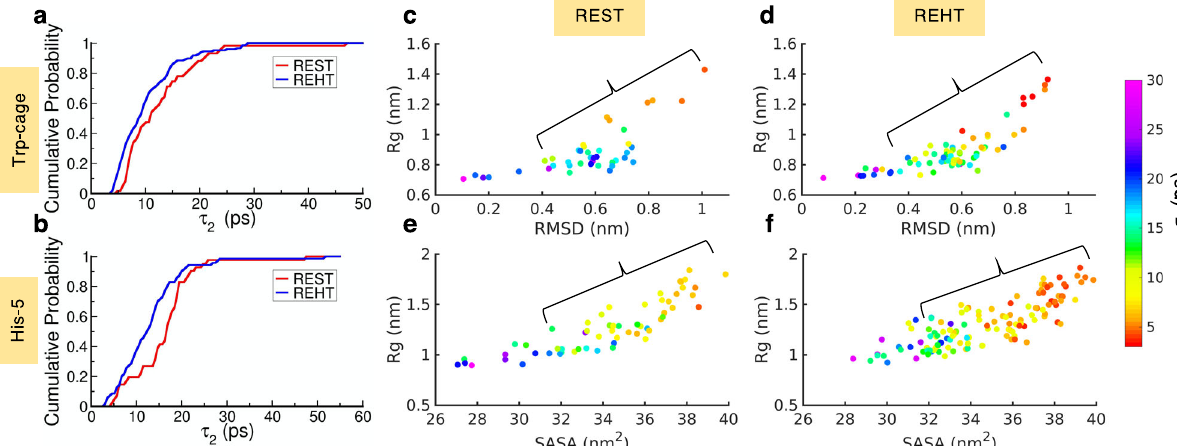
Fig. 6 Extent of hydration dynamics and its tight coupling with the conformational space sampling. In fi gure a , b we showed the cumulative distribution of the slow component of water orientational relaxation decay ( τ 2 ) in REST2 (red) and REHT (blue) simulations for Trp-cage ( a ) and His-5 ( b ). In c – f we projected the conformational space of Trp cage (across RMSD to the native NMR structure and Rg) and His-5 (across SASA and Rg) with the conformations color coded by the τ 2 value as indicated in the color bar. The region with signi fi cant entropic barrier is highlighted in all the systems. Since there are a lesser number of replicas in REST2 in comparison to REHT (8 vs 12 in Trp-cage, 10 vs 15 in histatin-5), the number of points analyzed also became lesser in